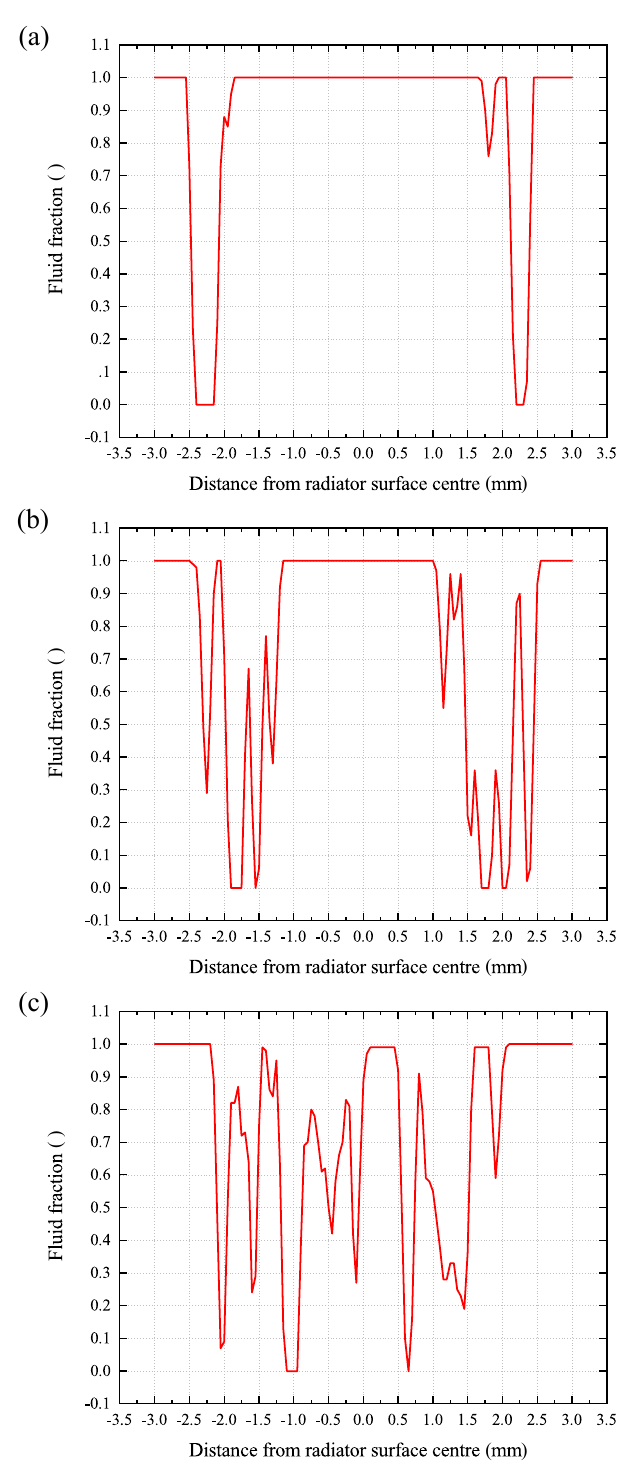
Figure 7. Fluid fraction analysis on the radiator surface: ( a ) t = 0.00027 s, ( b ) t = 0.00037 s and ( c ) t = 0.00097